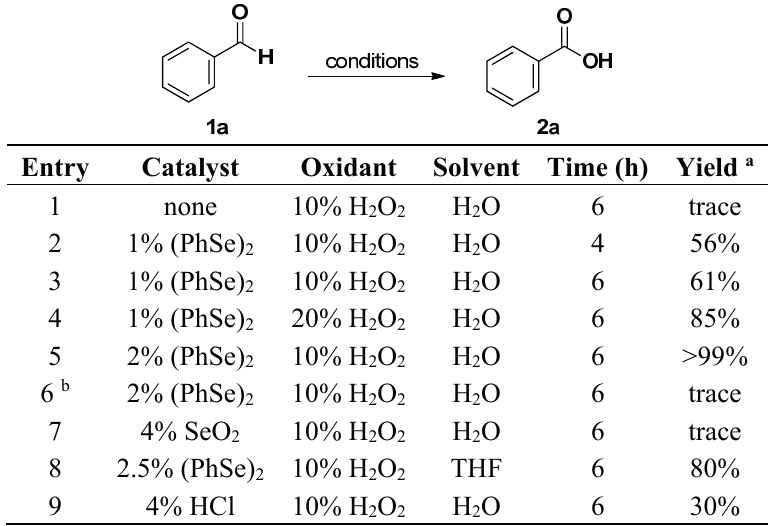
Table 1. Oxidation of benzaldehyde ( 1a ) into benzoic acid ( 2a